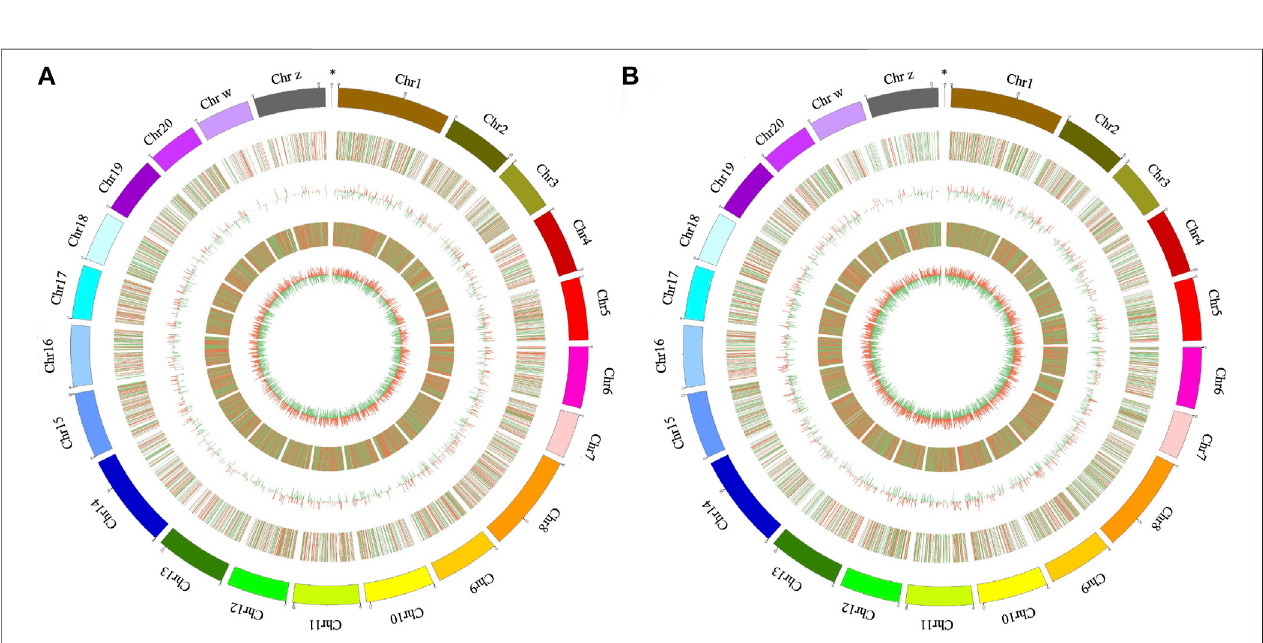
FIGURE3| CircosplotofDElncRNAsand mRNAsinthebrainintheovarianstagesIVvs.V (A) andstagesVvs.VI (B) comparison groups.Thecirclefromoutside to inside shows the autosomal distribution in tongue sole, the chromosomal locations of the DE lncRNA, the histogram of DE lncRNAs at different positions, the distribution of DE mRNAs on the chromosomes and the histogram of DE mRNAs at different positions, respectively; the red line represents upregulation, and the green line represents downregulation; higher columns indicate higher numbers of DE genes. The “ * ” symbol indicates the mitochondrial genome.